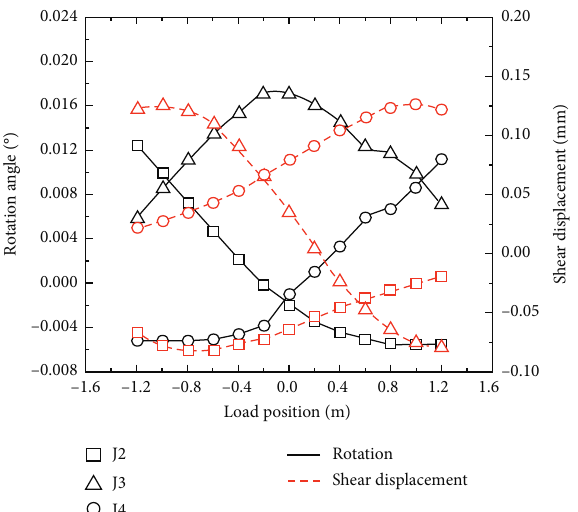
Figure 29: Influence of load position on joint rotation and shear